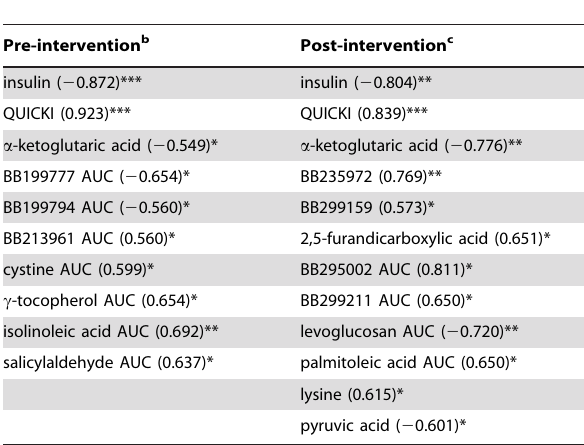
Table 5. Correlations of interest between Matsuda insulin sensitivity index and fasting plasma or post-OGTT metabolite area-under-the-curve (AUC) in adult women either pre- or post-weight loss and fitness intervention.